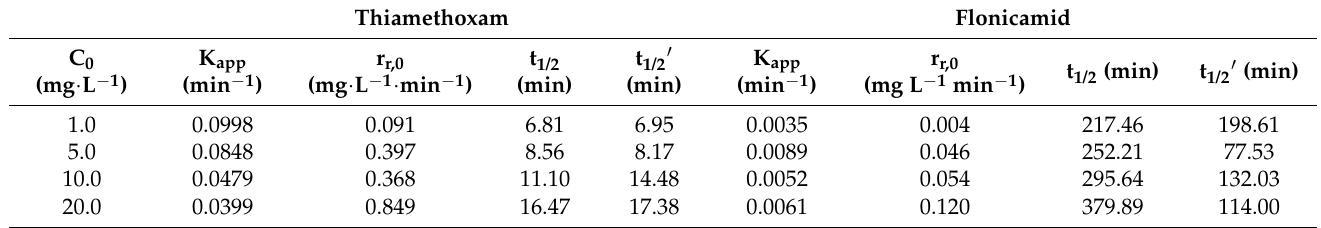
Table 1. Apparent pseudo first-order rate constants and initial reaction rates calculated for the different initial concentrations of TMX and FND. The presented half-life reaction times for both pesticides have been calculated at the examined initial concentrations.